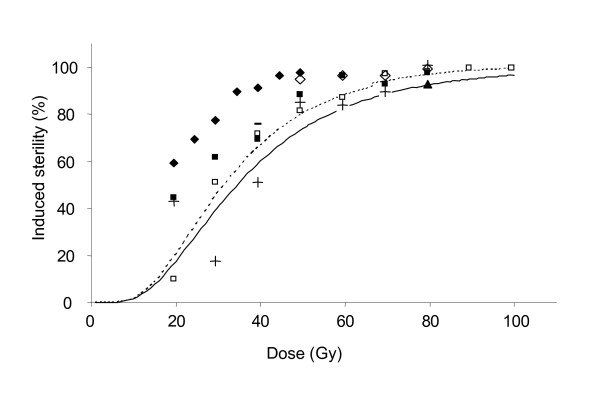
Comparative analysis of dose-sterility data from this study (solid line for An. arabiensis pupae, dotted line for adults) and published reports on anopheline irradiation (using 20–100 Gy). Induced sterility levels were calculated from observed sterility levels for [7,18]. +:An. albimanus pupa [17]; □: An. stephensi pupa [7]; ■: An. stephensi adult [20]; ◇: An. pharoensis pupa [18]; ◆: An. pharoensis adult [19]; ▲: An. gambiae adult [22]; -An. arabiensis adult [21].